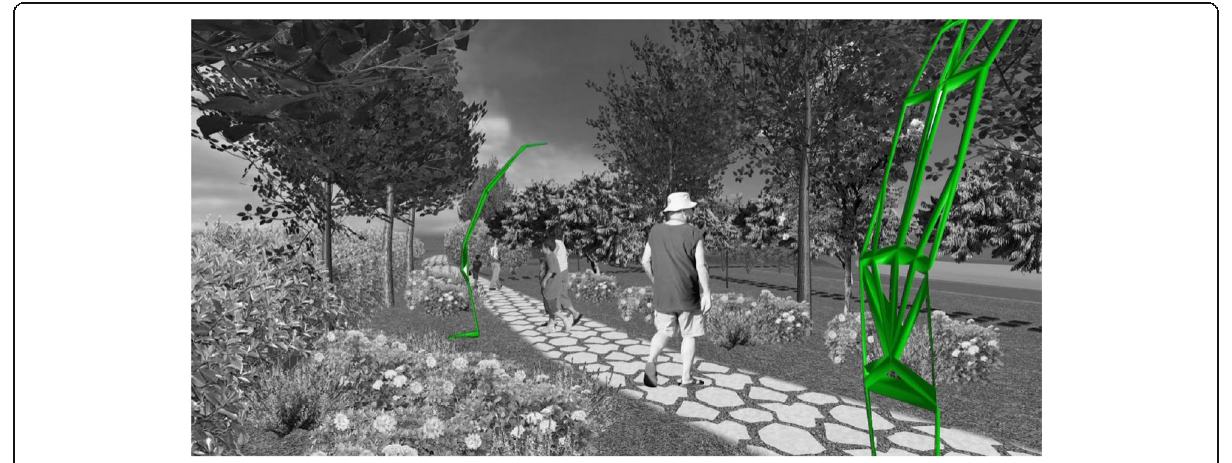
Fig. 13 Conceptual design of candelabra